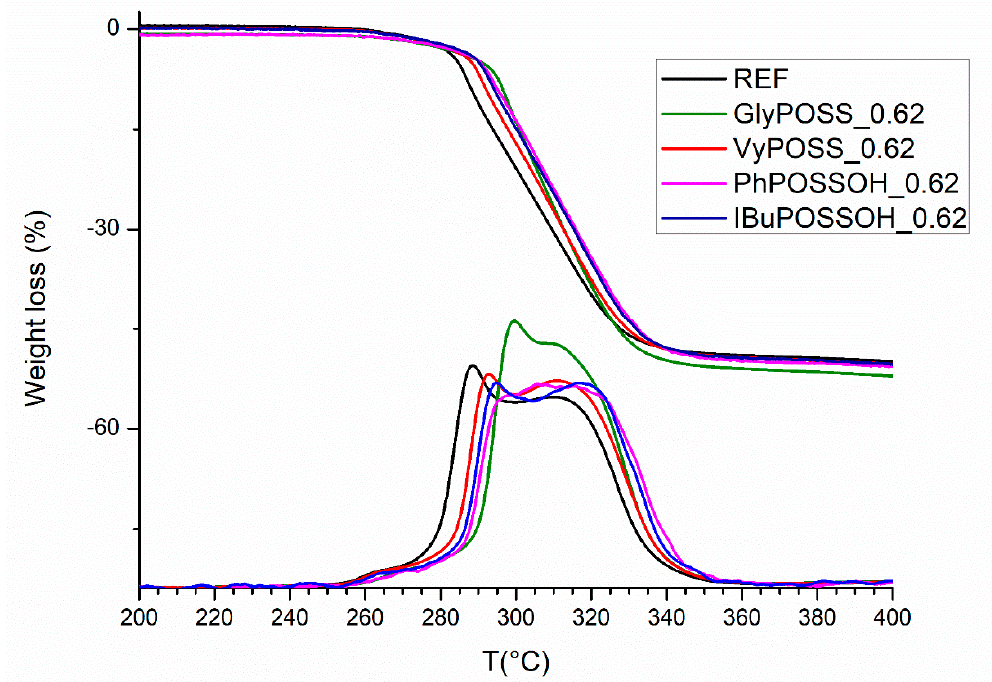
Figure 3. TGA / DTG analyses of reference P-PVC (REF, black) and POSS formulated P-PVC according to Table 2 formulations.